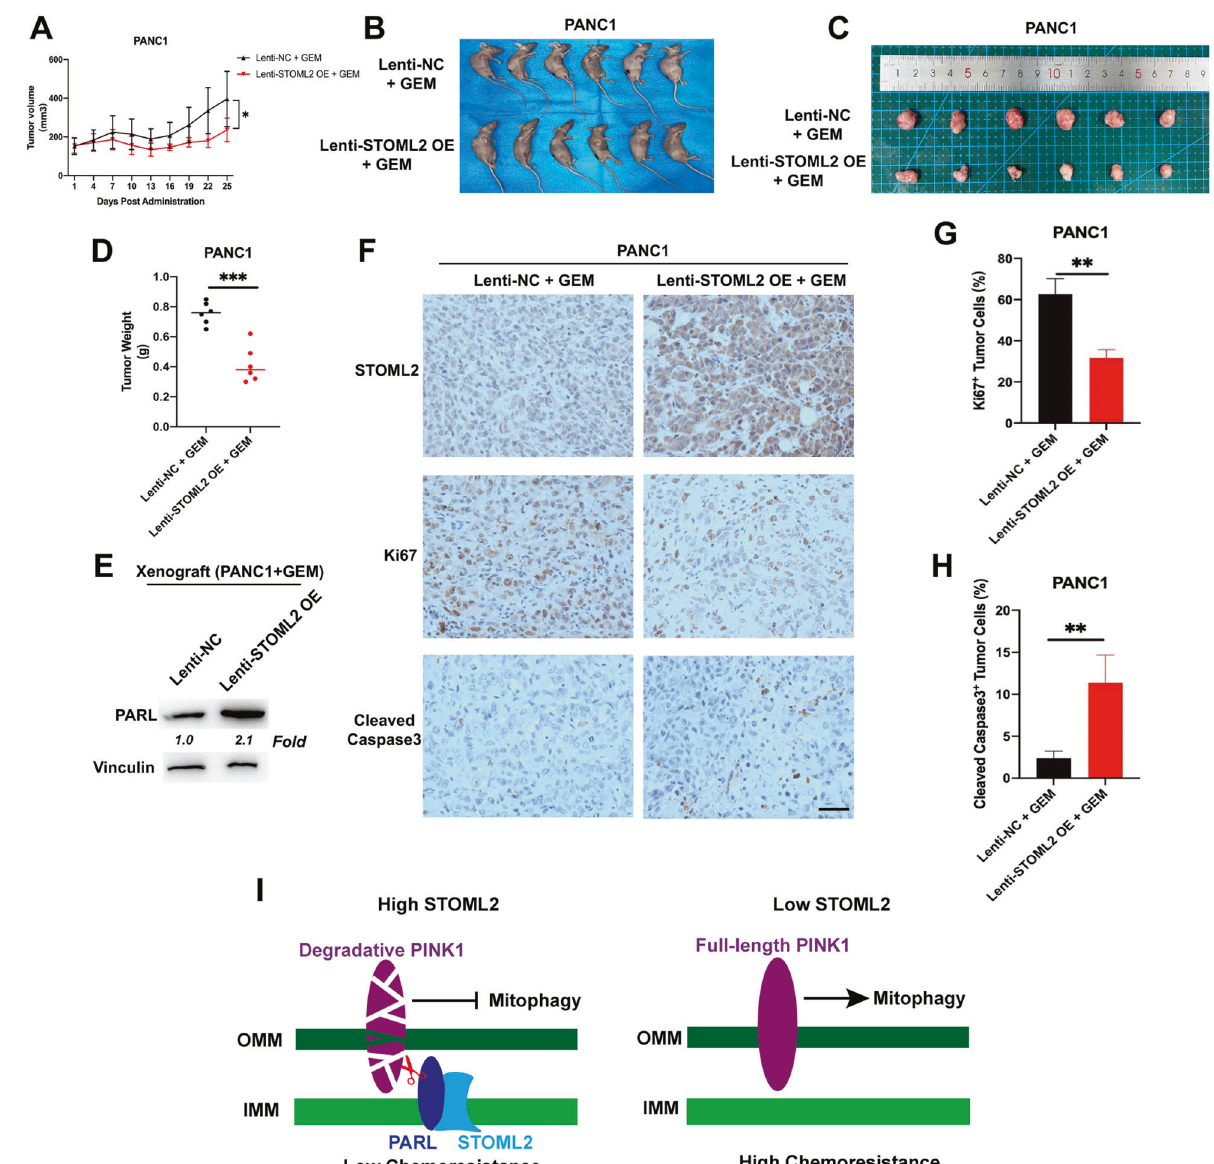
tumors. F IHC con fi rmed STOML2 overexpression in PANC1-lenti-STOML2 OE cells compared to control cells. F – H Cell proliferation and cell death in vivo were also analysed by IHC using anti-Ki67 and cleaved caspase 3, respectively. Scale bar represents 50 μ m G Graphical diagram of STOML2-inhibited mitophagy-induced chemoresistance in pancreatic cancer cells through the STOML2/PARL/PINK1 axis. OMM: outer mitochondrial membrane; IMM: inner mitochondrial membrane. * P < 0.05; ** P < 0.01; *** P <